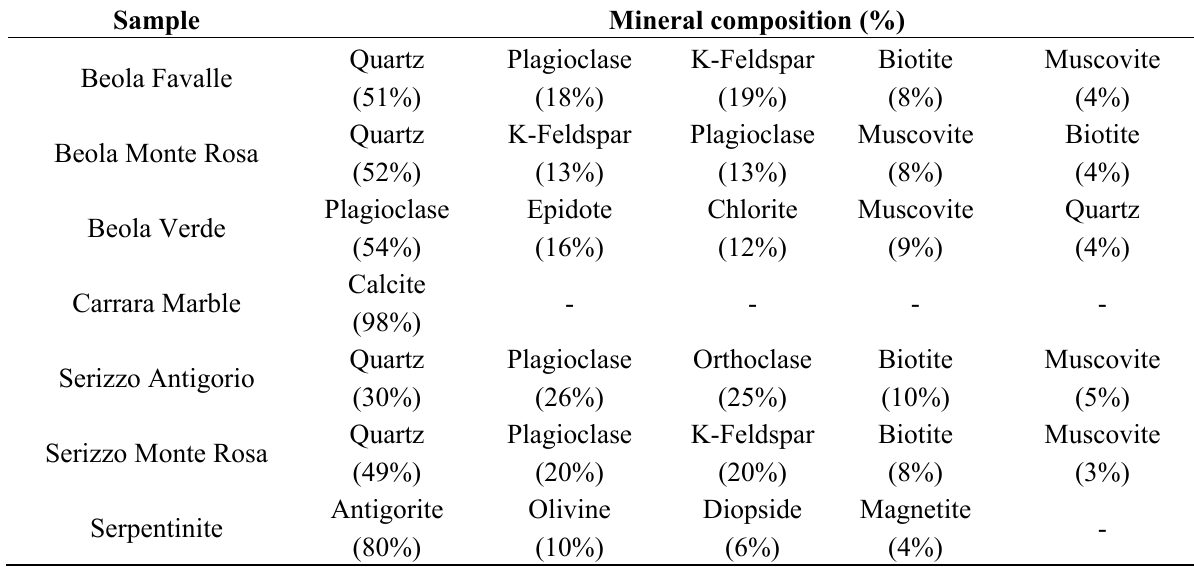
Table 1. Microscopic description of rocks used in this paper. Only main components are listed, resulting in a total percentage < 100 for some